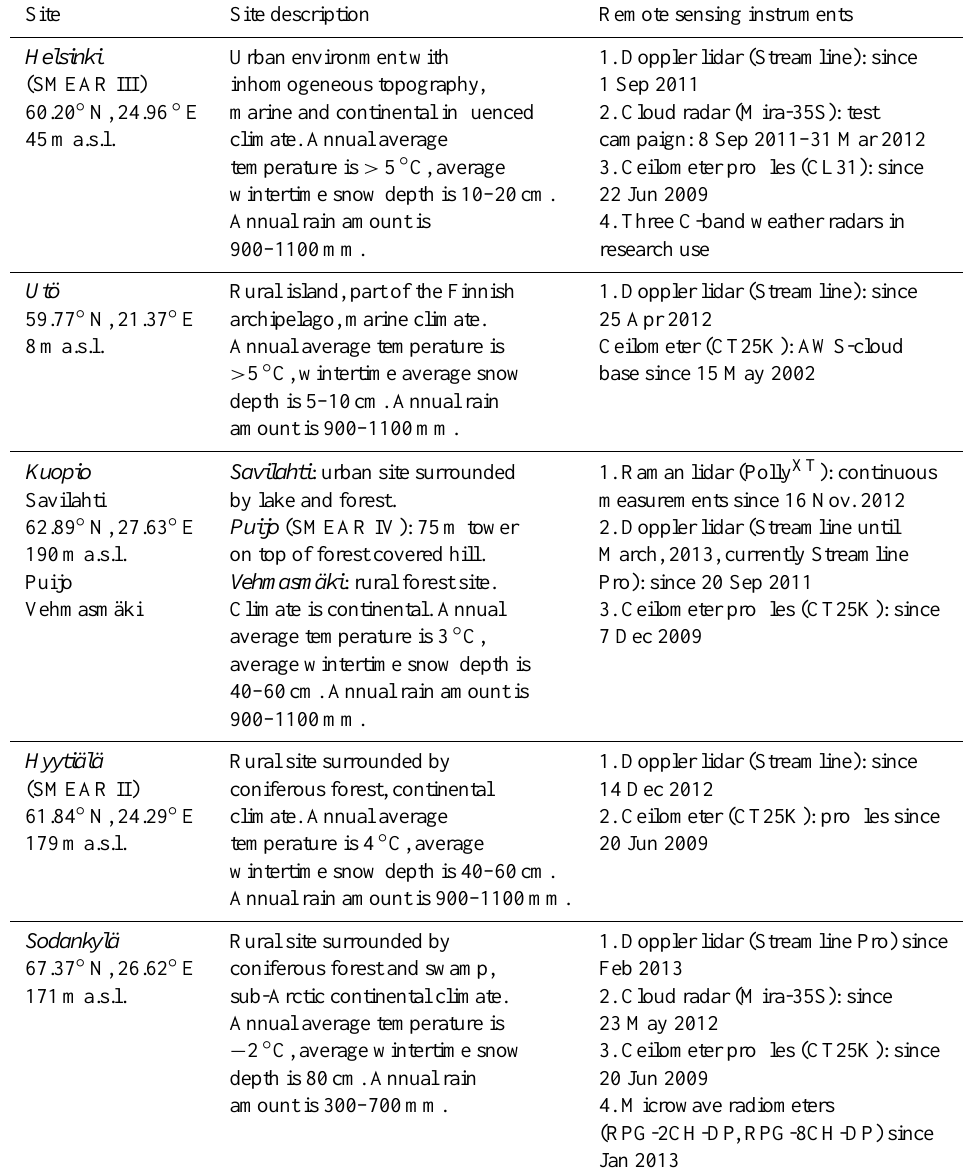
Table 1. Summary of the measurement sites within Finland’s ground-based remote-sensing network: AWS stands for automatic weather station. Doppler lidars are from HALO Photonics. Statistics of the average annual temperature, rain amount and wintertime snow depth are from FMI